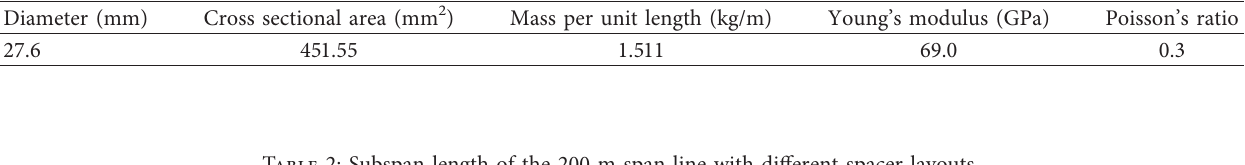
Table 1: Geometrical and physical parameters of conductor LGJ-400/50.